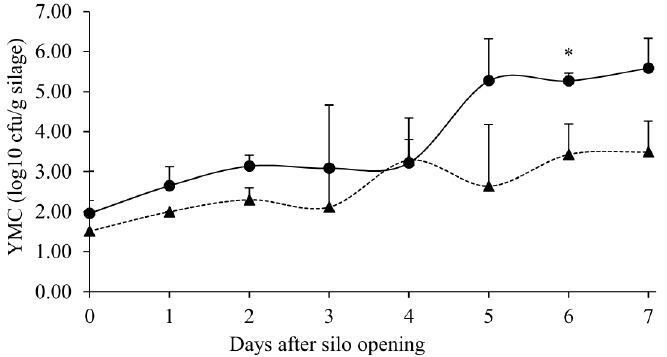
Figure 3. Changes in ( a ) pH, and ( b ) lactic acid concentration of 105-d ensiled bunker forages during aerobic exposure. Corn silage was treated without ( , n = 3) or with ( , n = 3) DPI. Asterisk (*) indicated that the slopes of linear regression lines differed significantly ( p < 0.05). Data were presented as mean ± SEM. SEYX: standard error of regression coefficient.